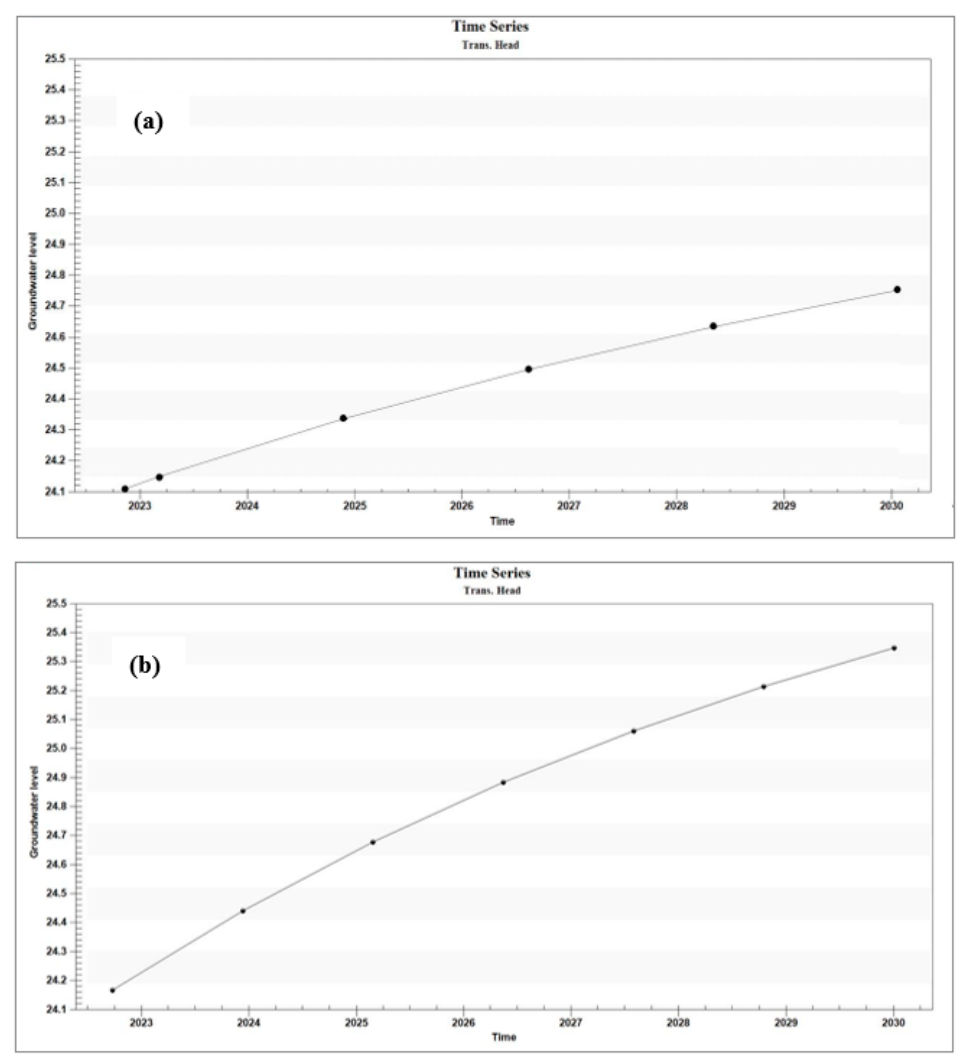
Figure 8. Changes in groundwater table (m.a.s.l) at the observation well No.3 ( a ) for SIM2 and ( b ) for SIM3 during the simulation period.